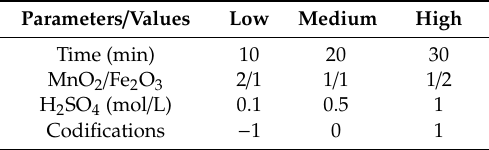
Table 2. Experimental conditions.